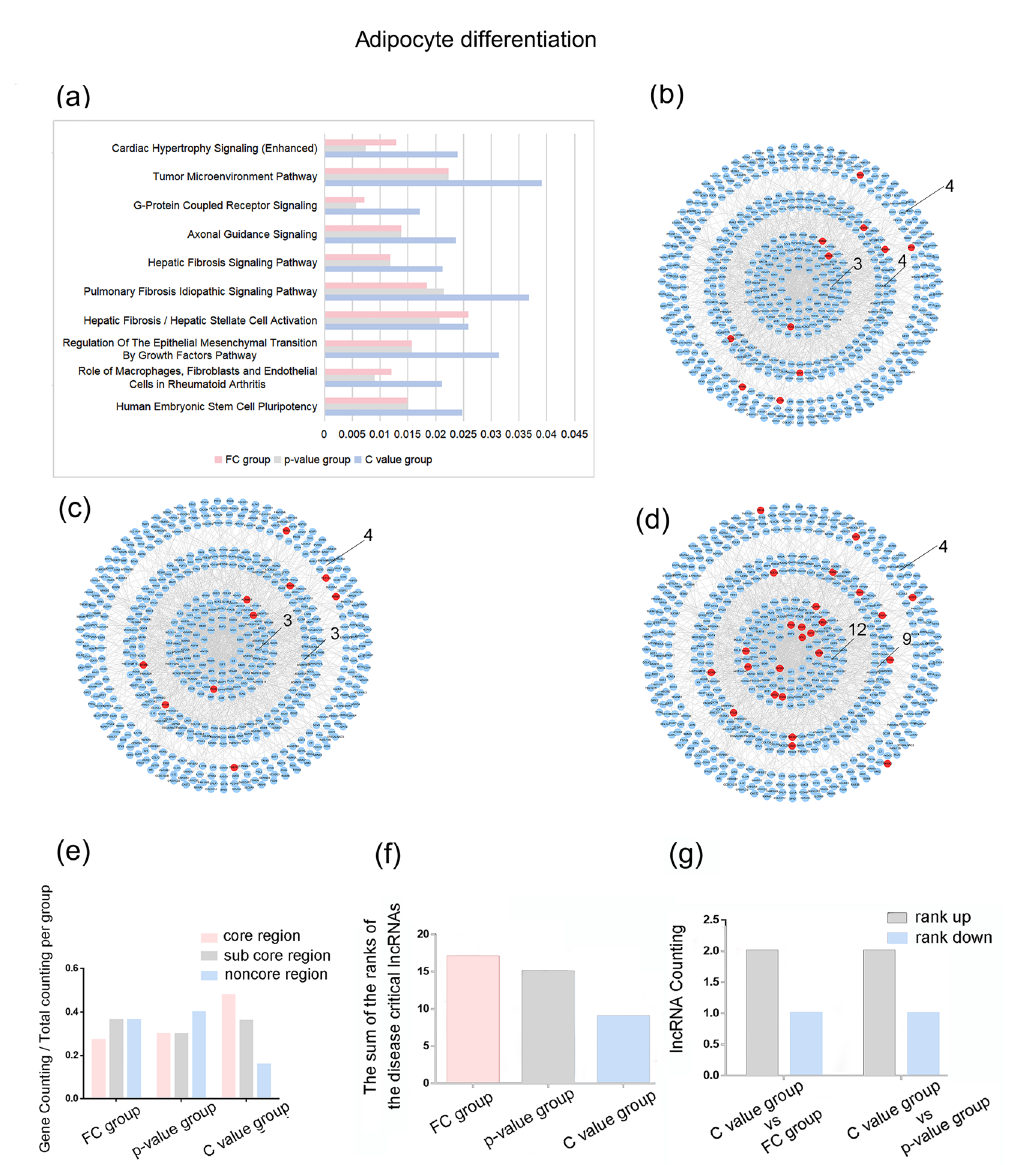
Figure 6. LncRNA operation results for adipocyte differentiation data set ( a ) The ratio of predicted target genes to the total genes in IPA canonical pathways. The distribution of ( b ) top10 FC, ( c ) top10 p-value and ( d ) top10 C value lncRNAs’ predictive target mRNAs in the PPI network. Number of genes in core region, sub core region and noncore region of each group was tagged. ( e ) The ratio of the number of genes in each group in different regions. ( f ) The sum of the ranks of adipocyte differentiation associated lncRNAs by the three indexes. ( g ) The number of adipocyte differentiation associated lncRNAs that rank up or down. (FC group: the collection of the top5 FC lncRNAs’ predictive target mRNAs; p-value group: the collection of the top5 p-value lncRNAs’ predictive target mRNAs; C value group: the collection of the top5 C value lncRNAs’ predictive target